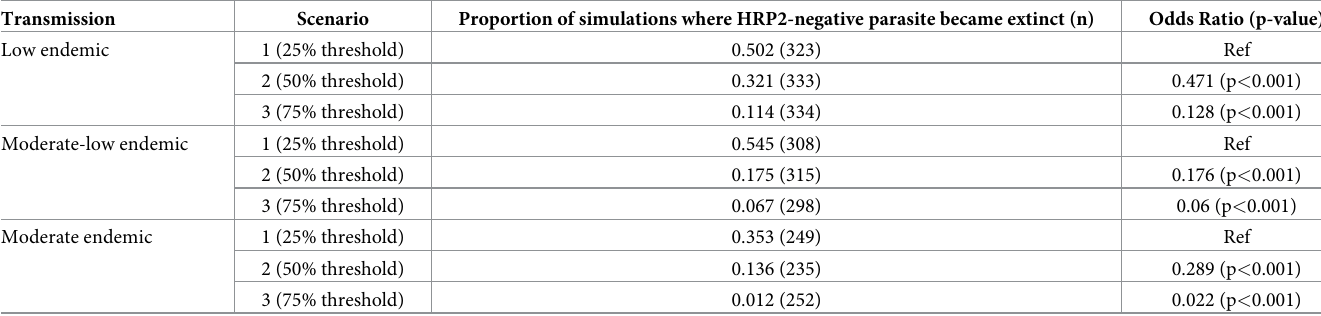
Table 1. Extinction of HRP2-negative parasites following RDT change. Transmission Scenario Proportion of simulations where HRP2-negative parasite became extinct (n) Odds Ratio